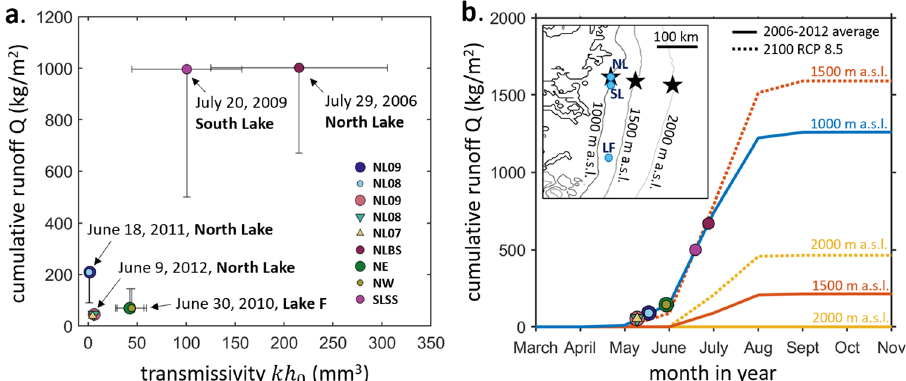
Fig. 4 Seasonal variation of hydraulic transmissivity. a Transmissivity inferred from fi ve drainage events across three lakes and the corresponding cumulative runoff at the lake drainage time. Cumulative runoff is the sum of daily, 11-km resolution RACMO runoff estimates 31 from the fi rst day of the year up to the drainage date at the nearest RACMO grid cell to the drainage location (Methods). Vertical error bars (Methods) show the difference in cumulative runoff estimates between RACMO 31 and MAR 34 runoff estimates. b Time evolution of cumulative runoff (monthly output) obtained from the regional climate model MAR averaged from 2006 to 2012 (solid curves) and its 2100-projections under the RCP 8.5 scenario 34 (dashed curves), evaluated at the three locations (elevations) marked as stars on the inset map (same map as the inset in Fig. 1c). The star at 1000 m a.s.l. is the North Lake location. The labels mark the day of year (DOY) of the drainage events and the corresponding 2006-2012 averaged cumulative